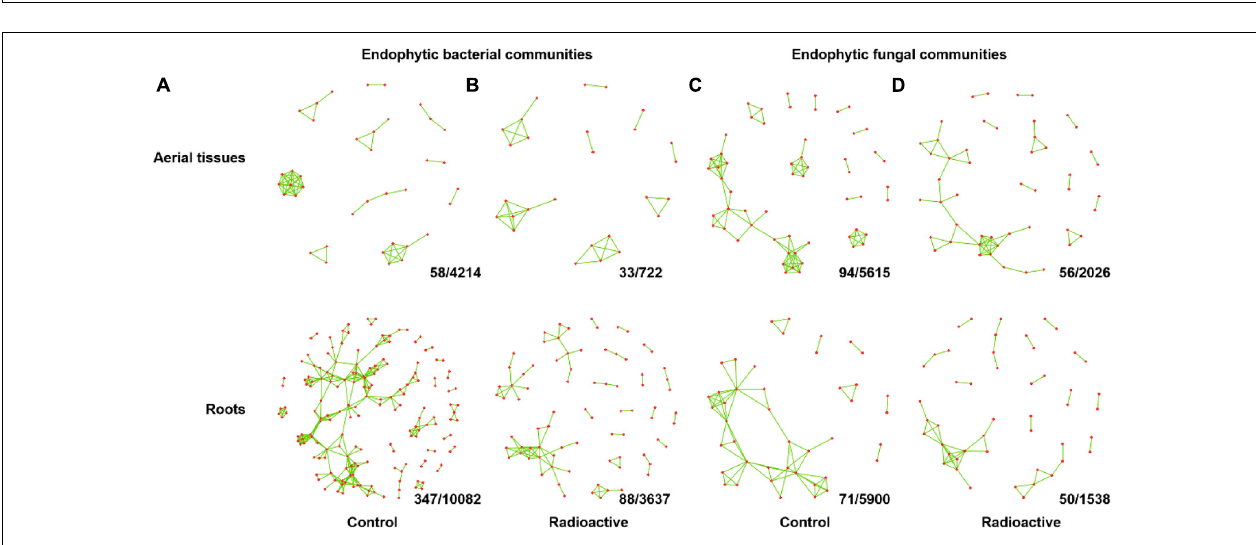
FIGURE 6 | Raup-Crick index was used to detect stochasticity for bacterial communities (A) and fungal communities (B) . Where | RCI| < 0.95, compositional variance is most likely due to stochasticity.